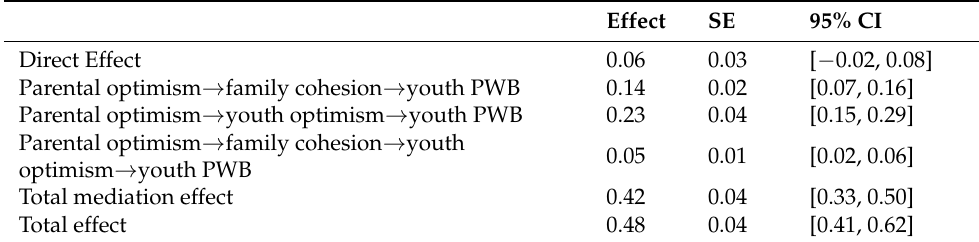
Table 3. Analysis of the mediation effects in the serial mediation